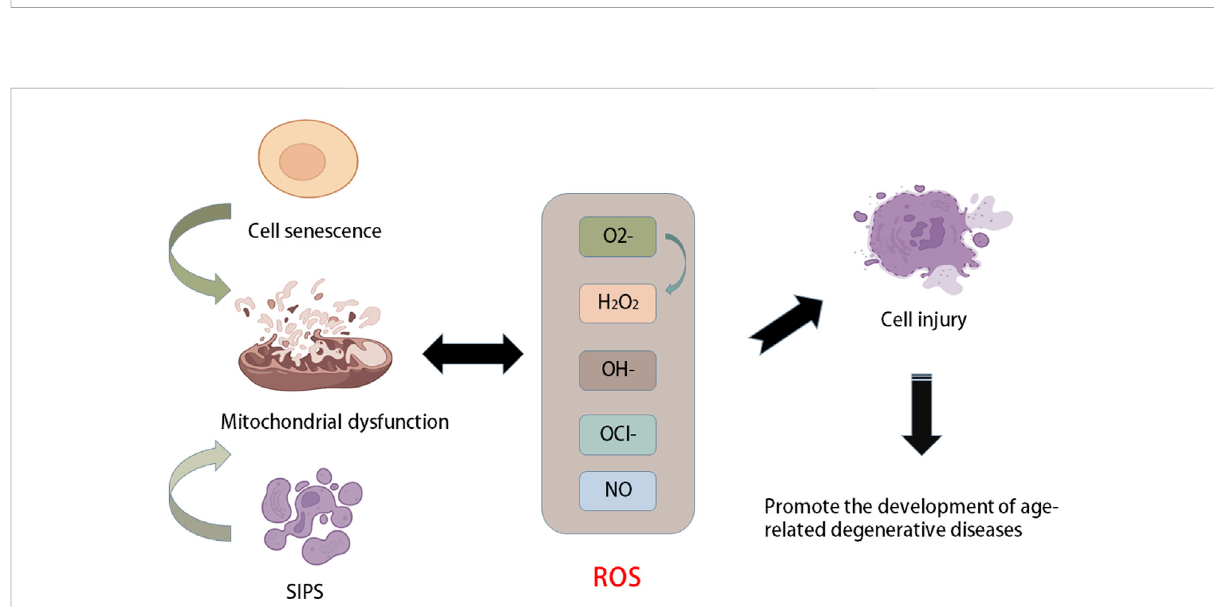
FIGURE 2 Relationship between aging and oxidative stress. Stress-induced premature senescence (SIPS) and natural senescence of cells can cause mitochondrial dysfunction, resulting in the production of a large number of ROS, such as oxygen anion (O 2 − ), hydroxyl radical (OH − ), hydrogen peroxide (H 2 O 2 ), NO and hypochlorite (OCl − ). When the production of ROS is greater than its own scavenging capacity, it will cause oxidative stress and cause cell damage and accelerate cell senescence, which further promotes the development of age-related degenerative